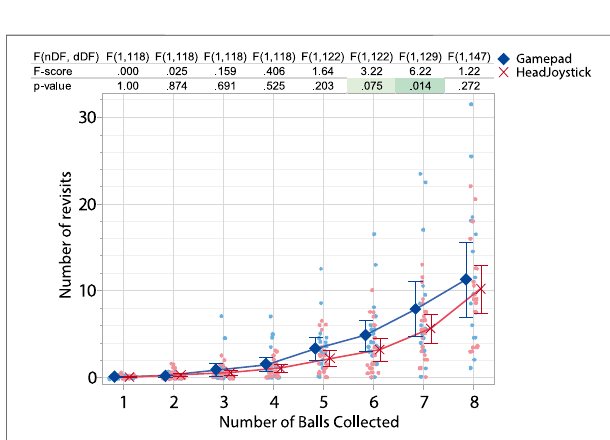
FIGURE 5 | Total target (boxes) revisited by the participants as they collected new balls. Light shades of dots represent the mean values per participant. A (blue) and X (red) indicate the mean for Gamepad and HeadJoystick interface respectively, CI (cid:2) 95%. Table above shows the planned contrast between the interfaces as the number of revisits accumulated with number of balls